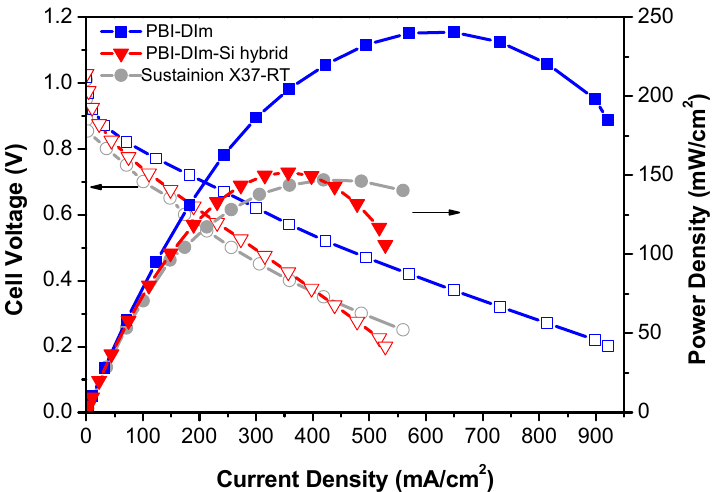
Figure 8. Fuel cell performance for the MEA based on the PBI-DIm, PBI-DIm-Si hybrid, and commercially available AEM Sistainion X37-RT.